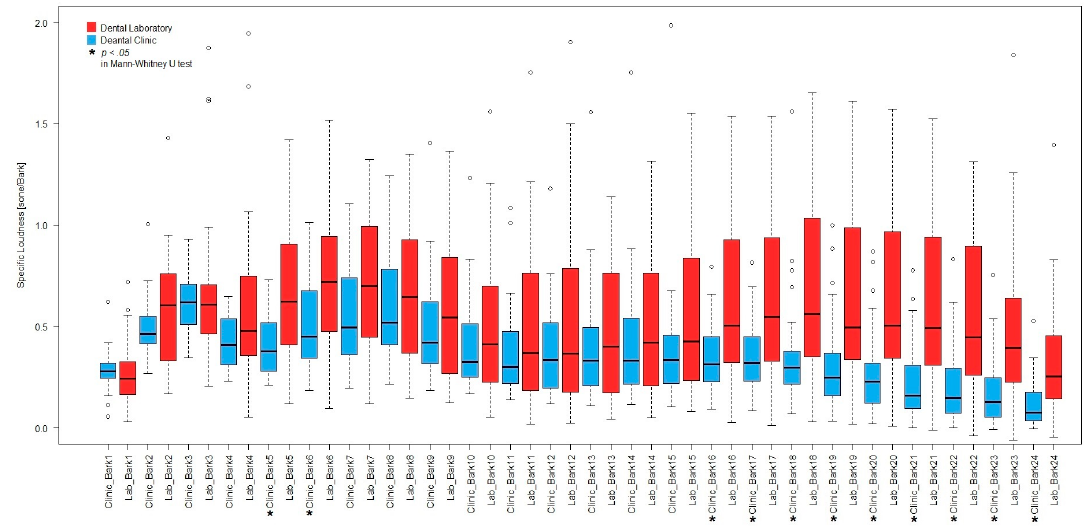
Figure 2. A combining boxplot of the averaged specific loudness changes of the noise at the dental clinic and the dental laboratory in 24 ‐ Bark band spectrum.